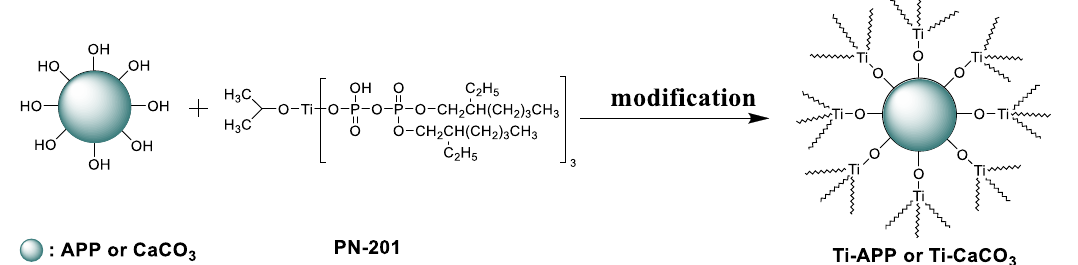
Figure 3. Mechanism of modified APP and CaCO 3.